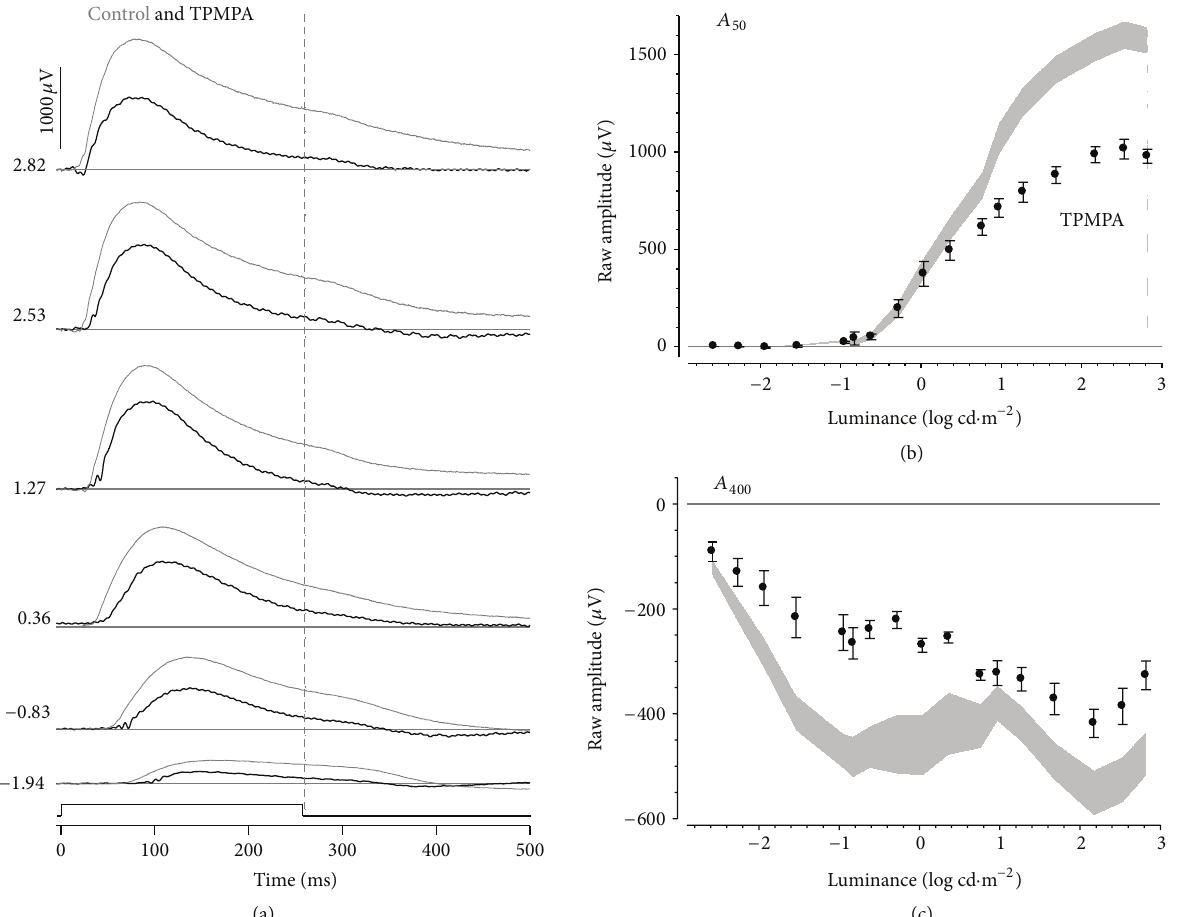
Figure 3: Effect of TPMPA on rat-isolated PII. (a) Representative TPMPA waveforms (thick) compared to its fellow control eye (thin). Lumi- nance is given in logcd ⋅ m −2 along the left. Grouped average ( ± SEM) amplitudes at fixed times of 50 (b) and 400ms (c) are plotted against luminance. TPMPA-treated (black filled) data are compared against control eyes (grey areas indicate 95% confidence intervals of controls as calculated from the